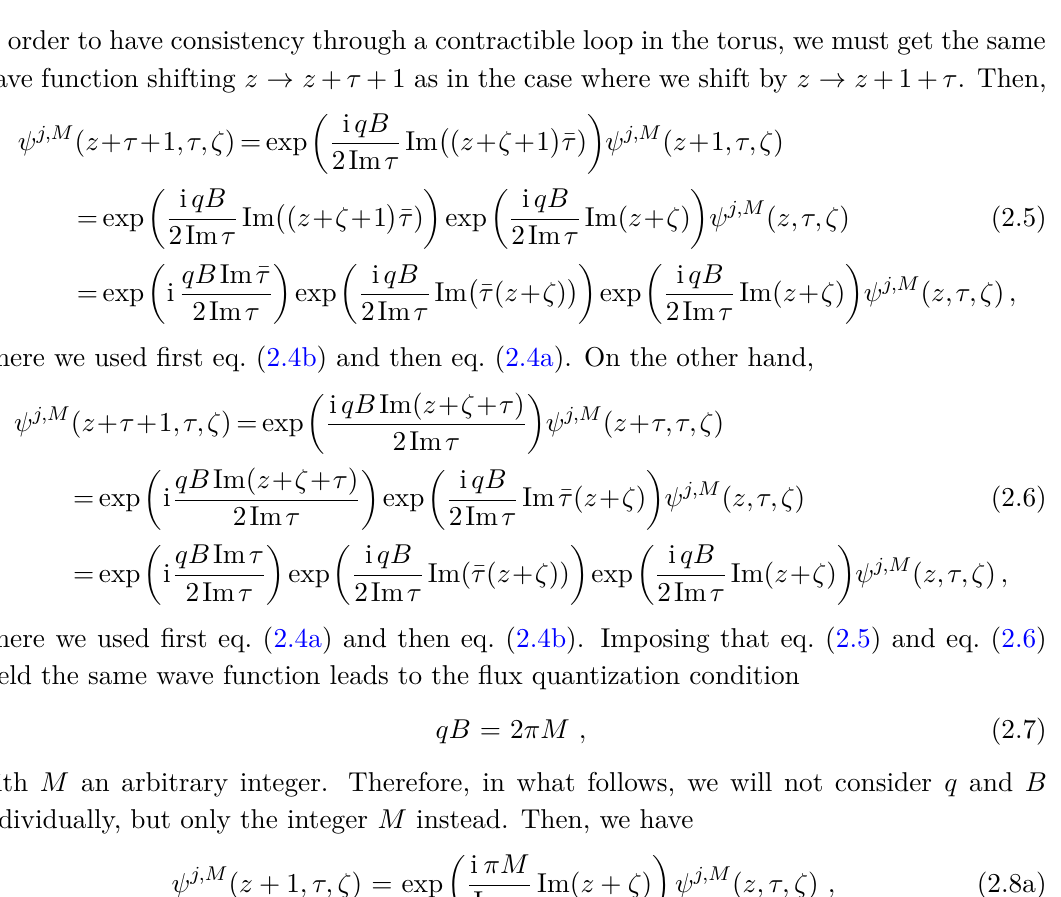
Figure 1. Squares of the absolute values of the wave functions on a quadratic torus for M = 4